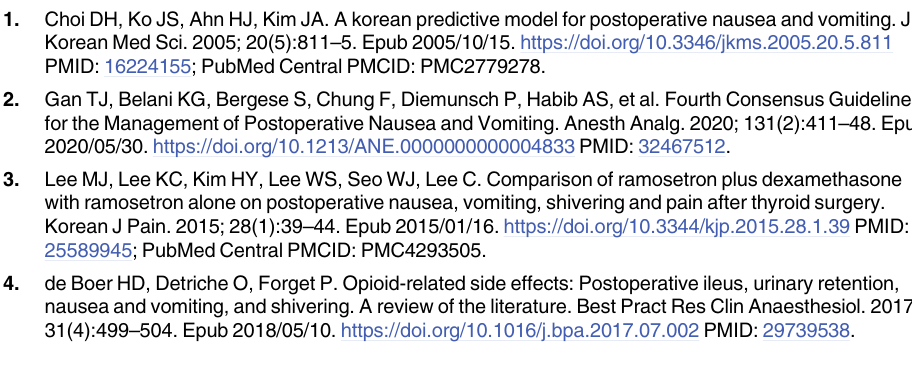
S1 Table. Optimal hyperparameters of all machine learning